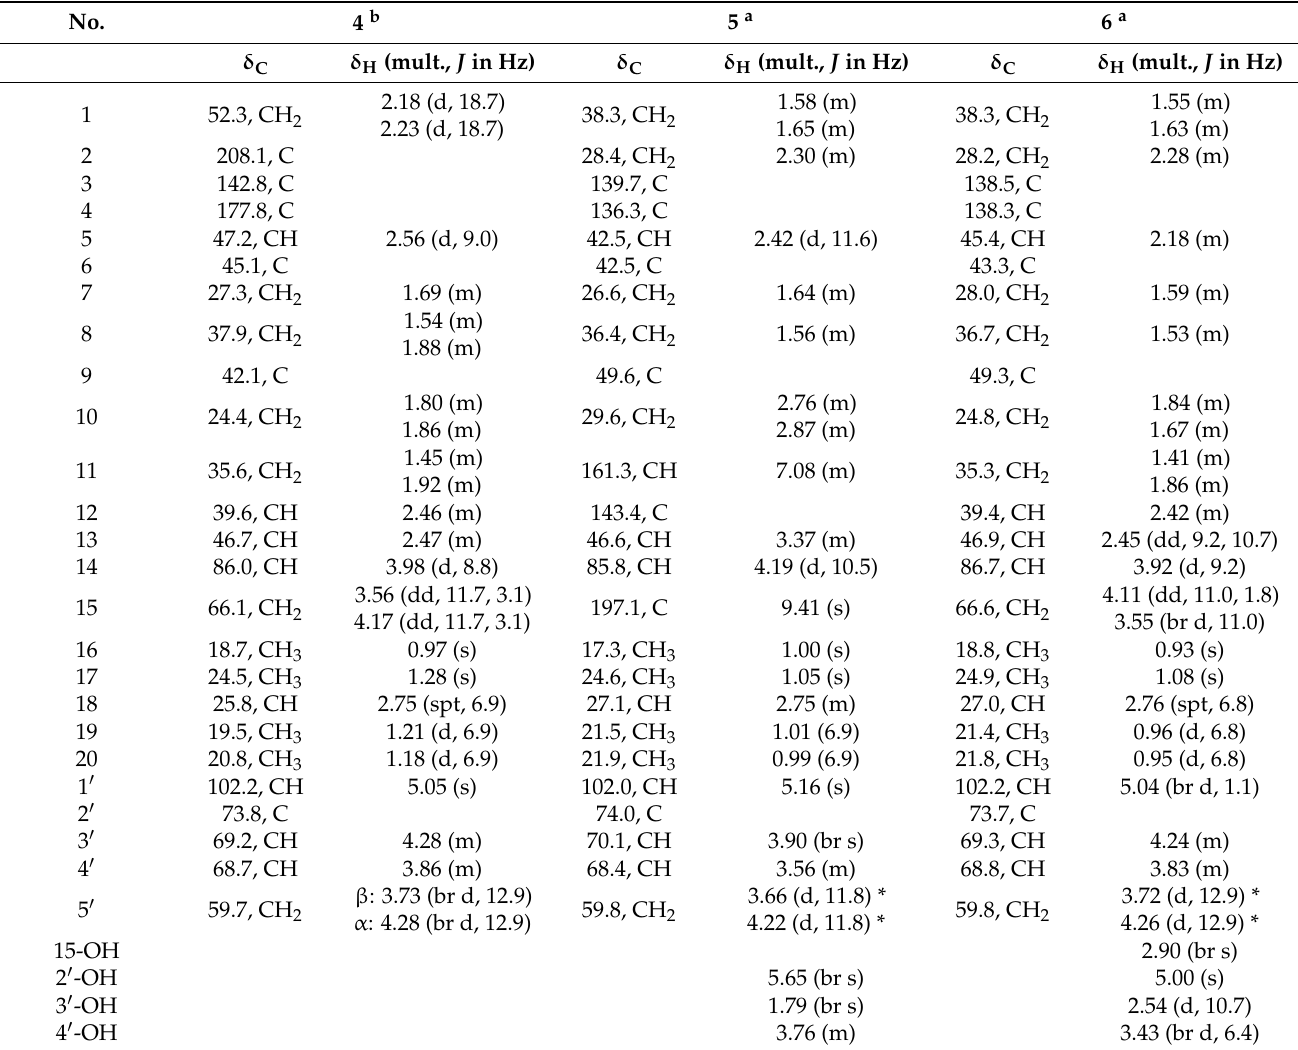
Table 2. 1D and 2D NMR spectroscopic data of compounds 4 – 6 .